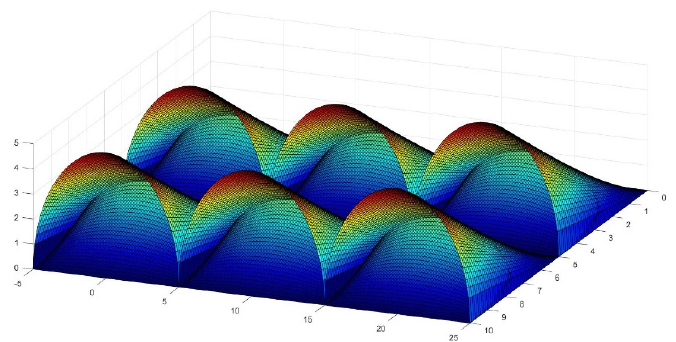
Figure 30. A suggested array of six conoidal skylights.